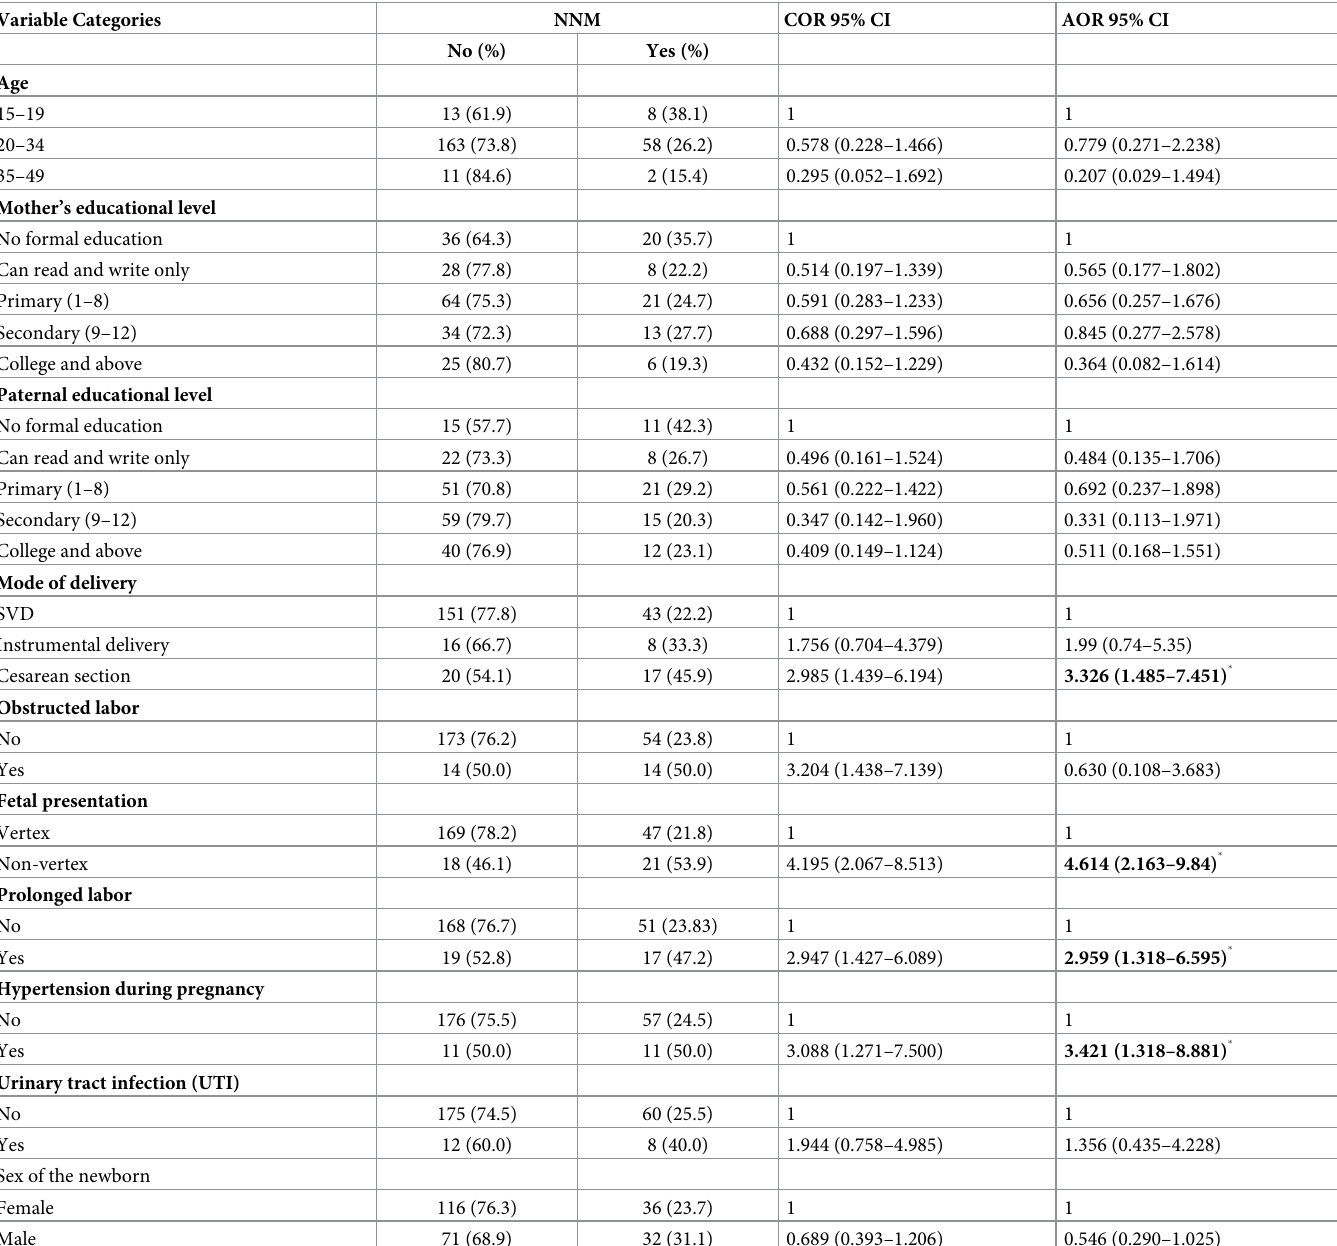
Table 4. Factors associated with NNM in selected public hospitals of Jimma zone, southwest Ethiopia, 2020 (n = 255). Variable